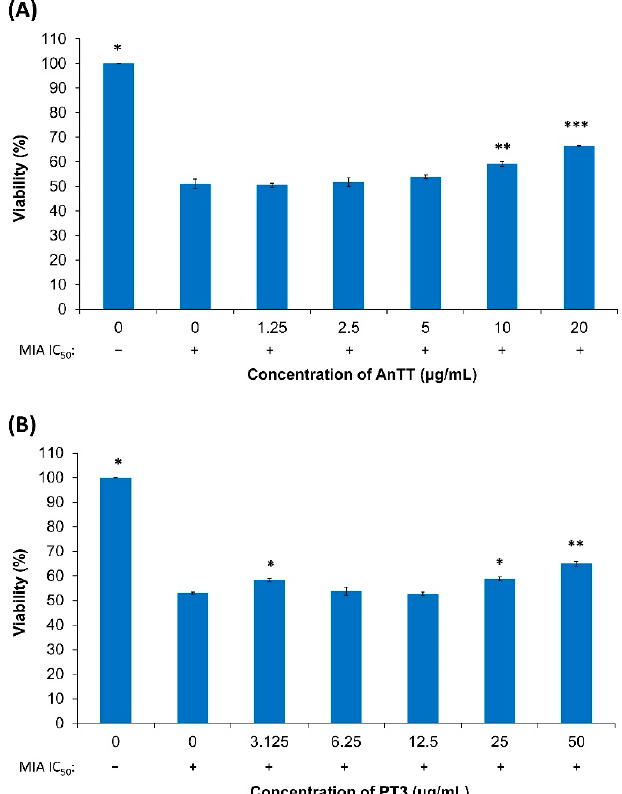
Figure 3. The viability of SW1353 chondrocytes over a 24 h concurrent treatment of AnTT ( A ) or PT3 ( B ) and MIA (IC 50 31.5 µM). The results were obtained from 3 independent experiments with 4 technical replicates during measurement. The data were displayed in mean ± SEM. *, ** and *** indicate a significant difference of p < 0.05, p < 0.01 and p < 0.001 respectively compared to the MIA control group.